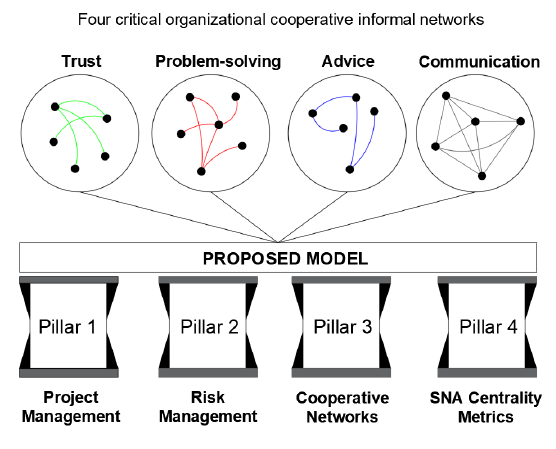
Figure 1. Proposed model´s four key Pillars and the four critical organizational cooperative informal networks. Table 1. Individual contributions of each of the four Key Pillars that form the base to the development of the proposed model in this